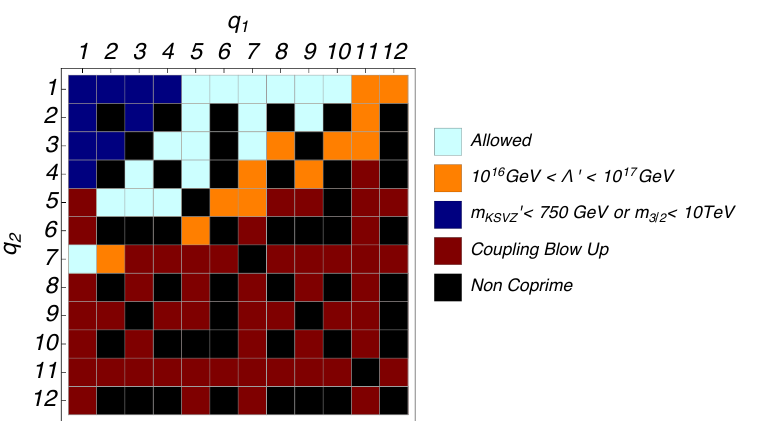
Figure 1 . Constraints on charges q 1 and q 2 in the SU(3) 0 model for N GCD = 1. The allowed charges are colored by light blue and orange, although the orange colored charges are allowed only for (cid:3) 0 & M GUT . The charges colored by blue lead to too large (cid:18) e(cid:11) or too light KSVZ extra multiplets. The gauge coupling constants of the SSM blow up below the GUT scale for the charges colored by red. The black colored charges are excluded as they are not relatively